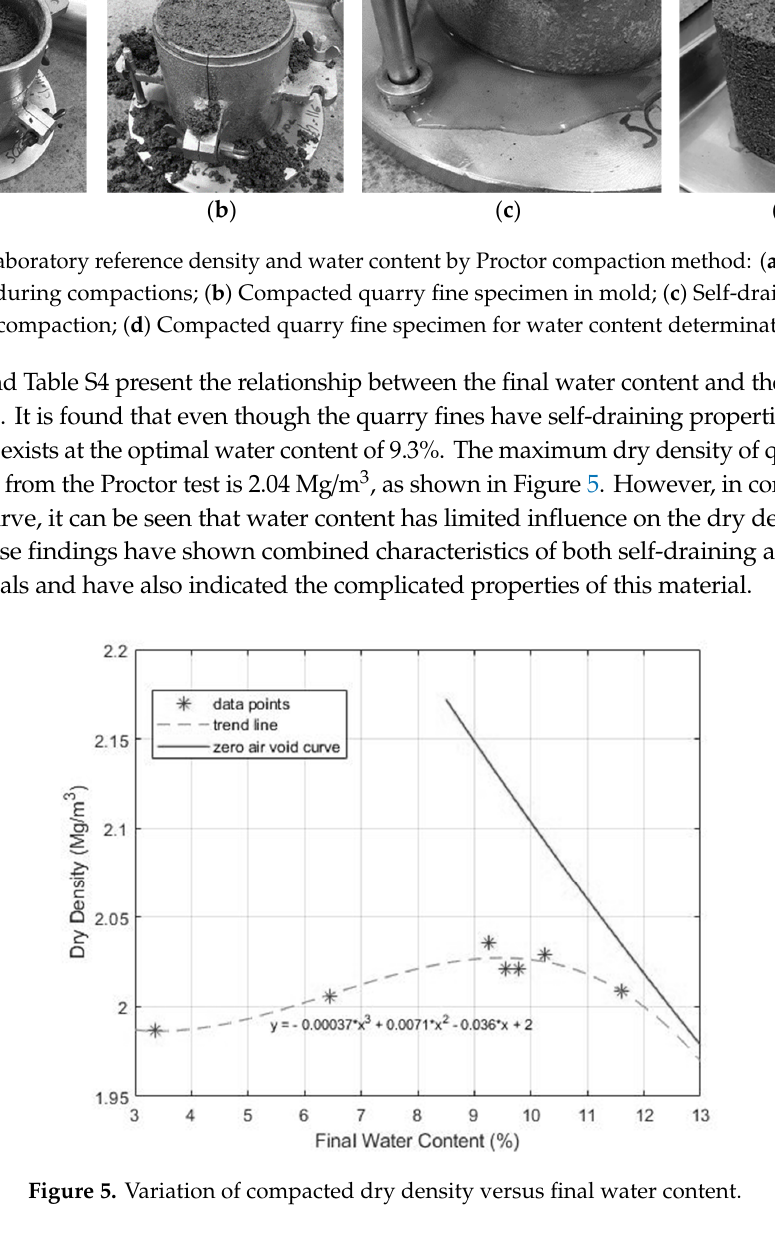
Figure 5. Variation of compacted dry density versus final water content.